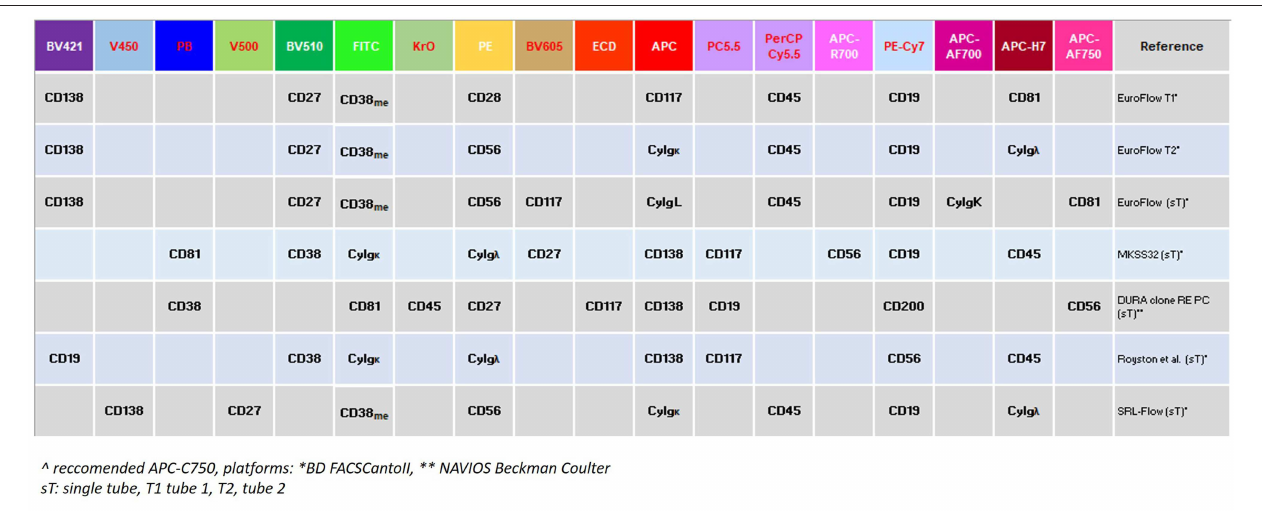
FIGURE 3 | 6-8-10 color panels used in MFC/MRD